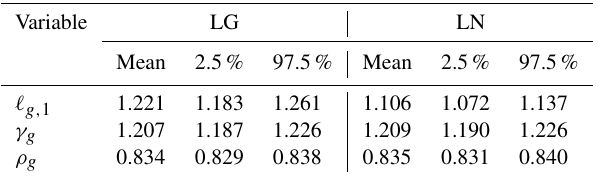
Table 5. Posterior means, 2.5% quantiles, and 97.5% quantiles for the parameters (cid:96) g, 1 , γ g , and ρ g for the inversions using LG and LN retrievals. Recall that the parameters associated with LG and LN are derived from different inversions and not from using the two retrieval groups in the same